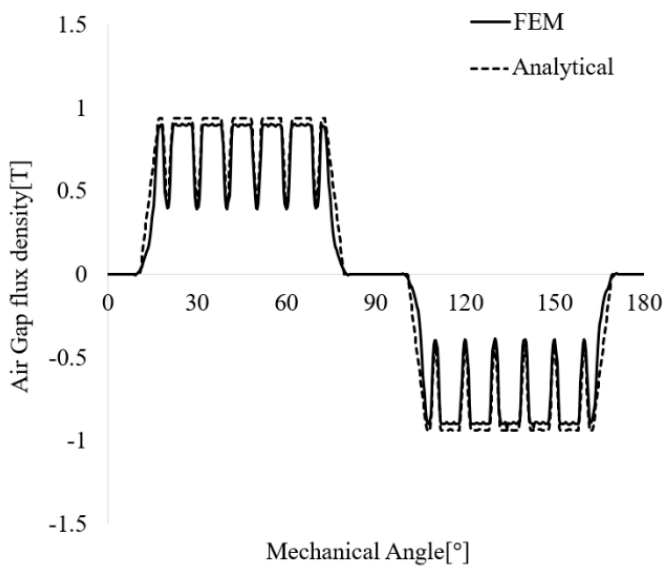
Figure 8. Comparison of the air gap flux density distribution by permanent magnet with slots derived from the HMEC and FEM .